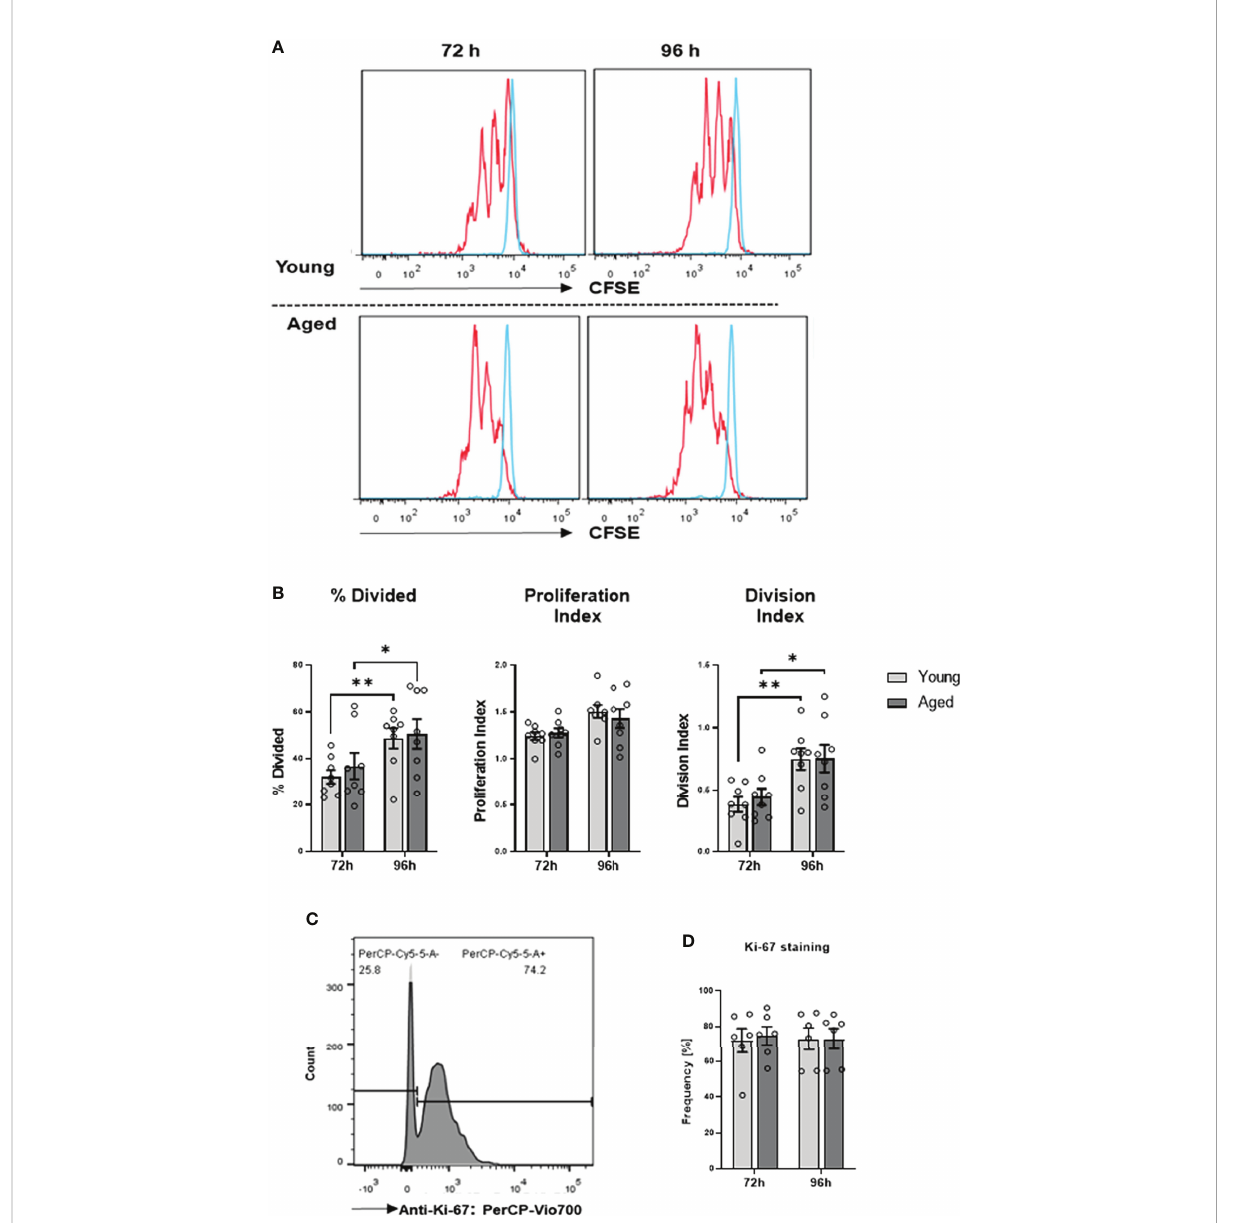
FIGURE 5 Proliferation of memory CD4 + T cells. (A) Representative example of fl ow cytometric analysis for CFSE stained memory CD4 + T cells from young and aged donors after 72 h and 96 h of TCR stimulation. (B) Comparison of division index, proliferation index, and percentage divided cells between memory CD4 + T cells from young donors and aged donors after 72 h and 96 h of TCR stimulation (mean ± SEM; n = 8 per group and time point). (C) Representative example of Ki-67 positive memory CD4 + T cells acquired by fl ow cytometry. (D) Comparison of Ki-67 positive memory CD4 + T cells from young donors and aged donors after 72 h and 96 h of TCR stimulation (mean ± SEM; n = 6 per group and time point). Multiple comparisons were analyzed by two-way ANOVA with the Bonferroni multiple comparison post hoc test. *P<0.05, **P<0.01 (B, D)